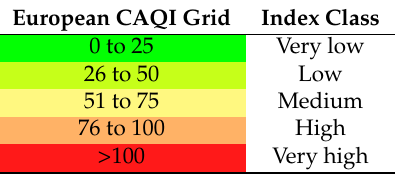
Table 3. European Common Air Quality Index (CAQI) grid with index